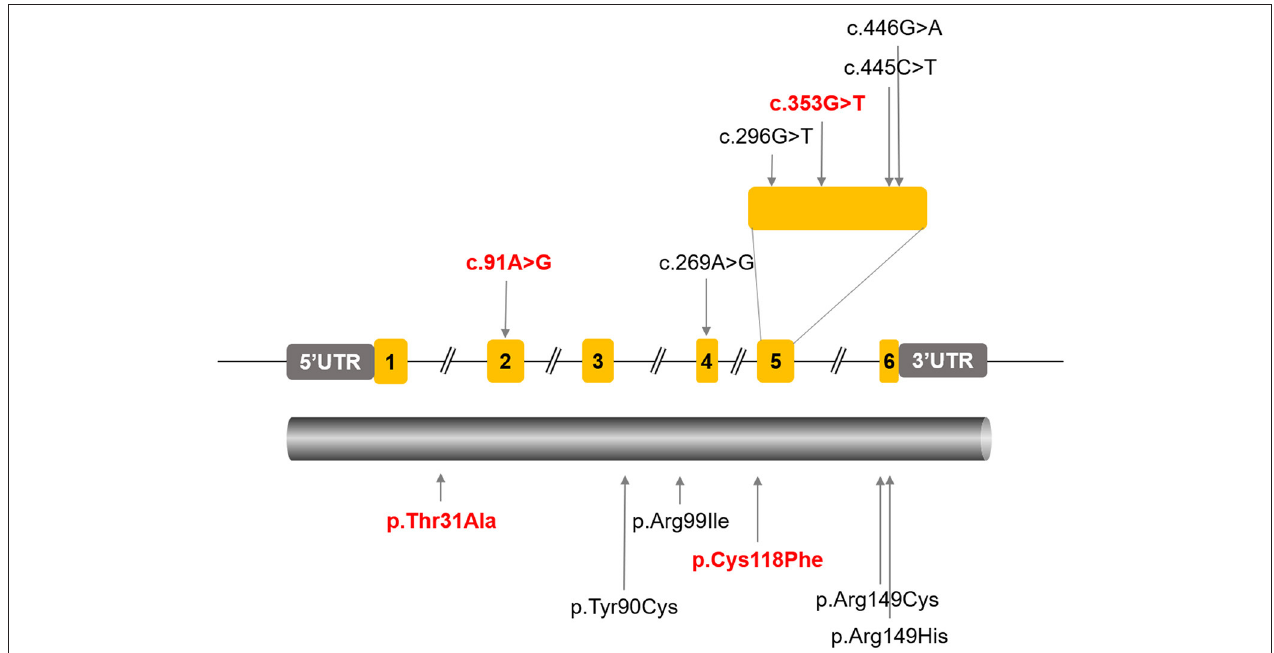
FIGURE 7 | All the reported ARL3 pathogenic mutations were labeled in the schematic diagram of ARL3 gene and protein. The ARL3 mutations c.91A > G (p.T31A) and c.353G > T (p.C118F) were indicated in